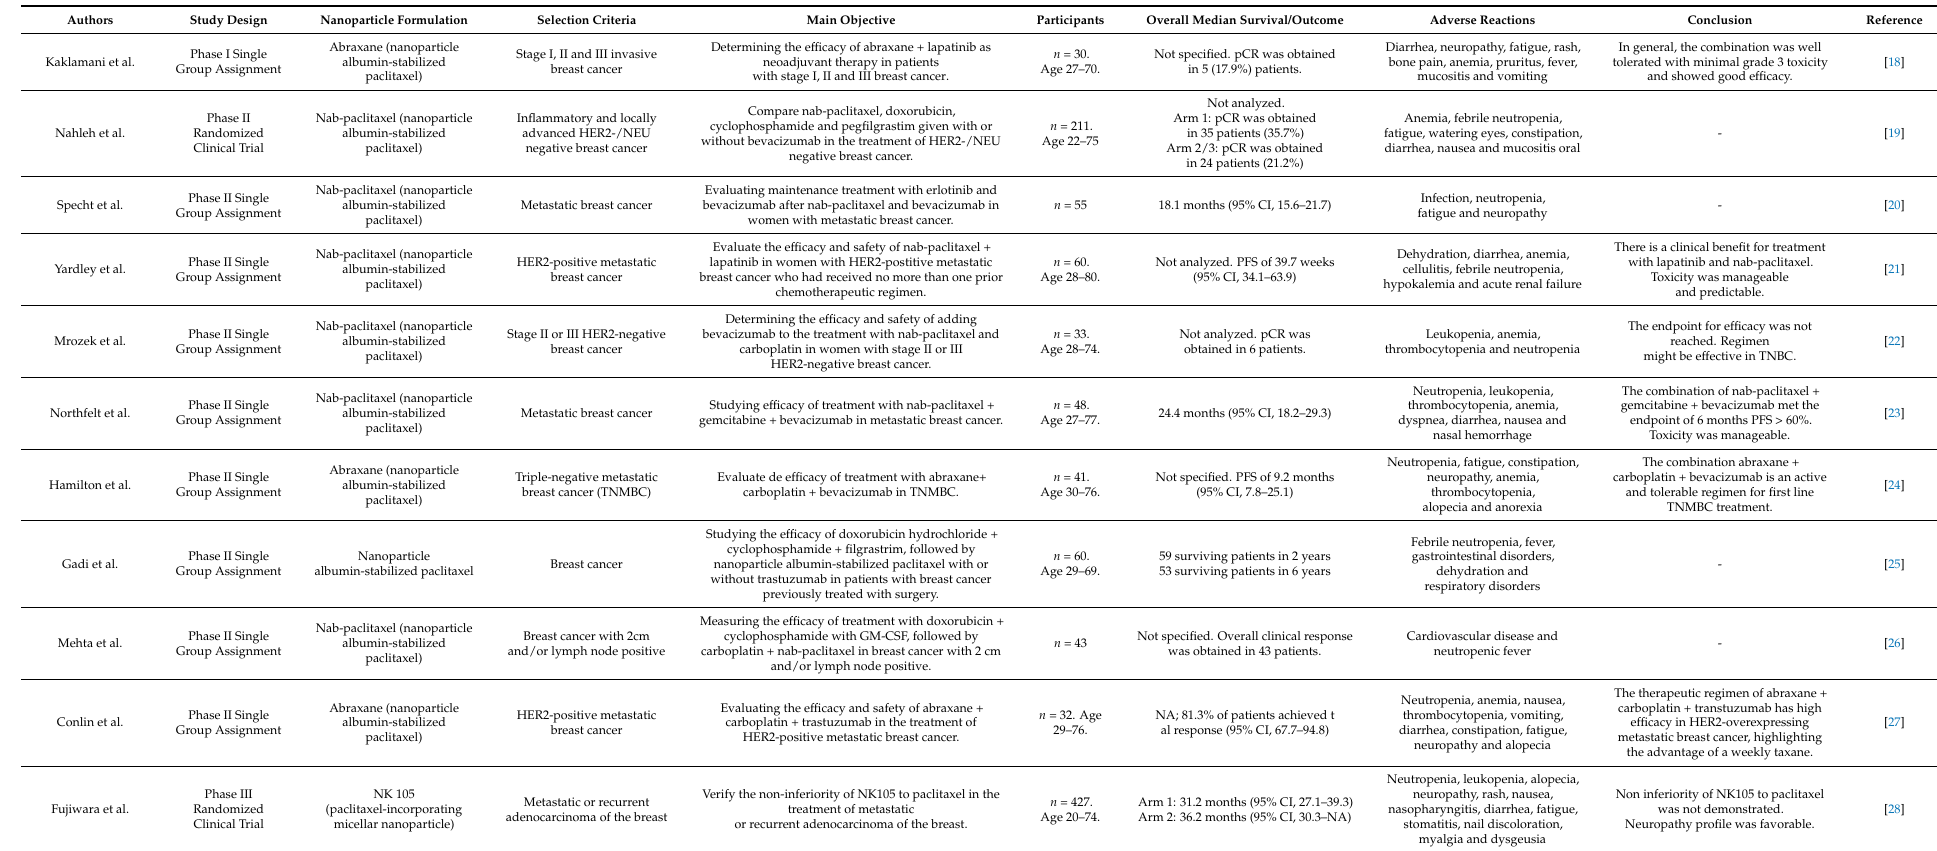
Table 3. Summary of results associating nanoparticles with breast cancer. Ten clinical trials used nab-paclitaxel in the treatment of breast cancer, one phase I study and nine phase II studies. One phase III clinical trial used a paclitaxel-incorporating micellar